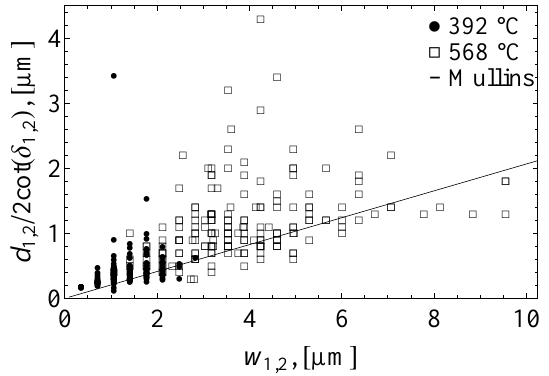
Figure 10. Cross-correlation of weighted groove depth and groove width for annealing at indicated temperatures, 200MPa and a dura- tion of 24h. The line represents the expected correlations according to the Mullins’ theory (see Eqs. 5 and